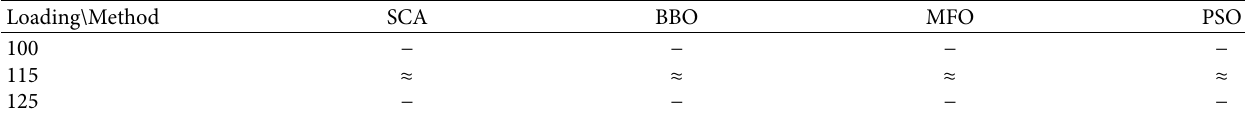
Table 3: WSRT results on IEEE 30 bus system.